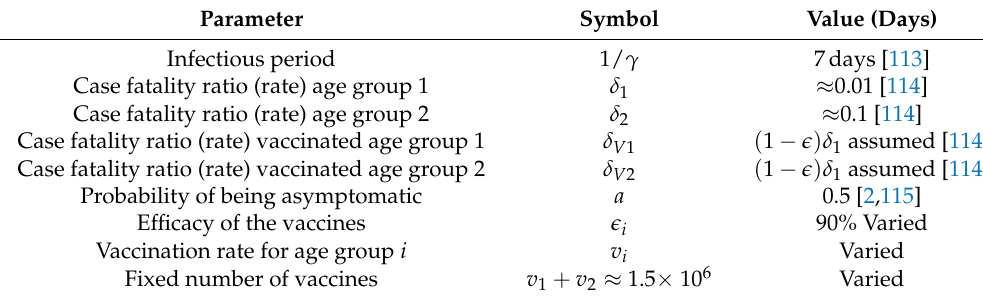
Table 2. Parameters’ values used in the simulations. Parameter Symbol Value (Days) Infectious period 1/ γ 7days [113] Case fatality ratio (rate) age group 1 δ 1 ≈ 0.01 [114] Case fatality ratio (rate) age group 2 δ 2 ≈ 0.1 [114] Case fatality ratio (rate) vaccinated age group 1 δ V 1 ( 1 − (cid:101) ) δ 1 assumed [114] Case fatality ratio (rate) vaccinated age group 2 δ V 2 ( 1 − (cid:101) ) δ 1 assumed [114] Probability of being asymptomatic a 0.5 [2,115] Efficacy of the vaccines (cid:101) i 90% Varied Vaccination rate for age group i v i Varied Fixed number of